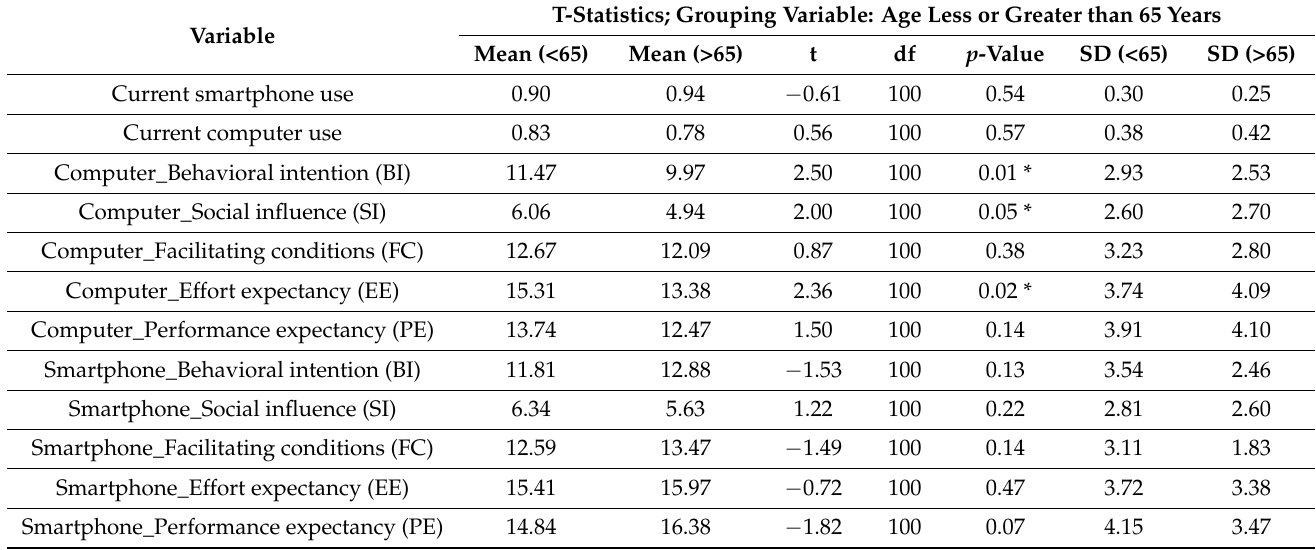
Table 2. Difference between age groups in current technology use and technology use acceptance (T-Statistics).